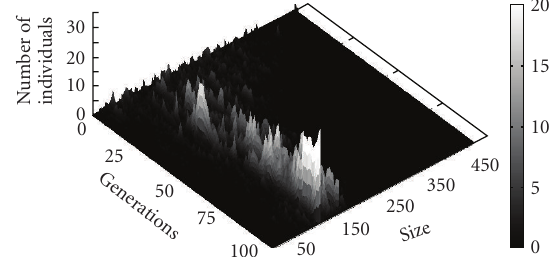
Figure 8: Symbolic regression Experiment 3: chromosome size in the population.